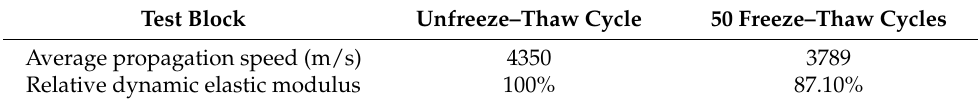
Table 5. Variations of velocity and relative dynamic elastic modulus of the concrete cubic test block. Test Block